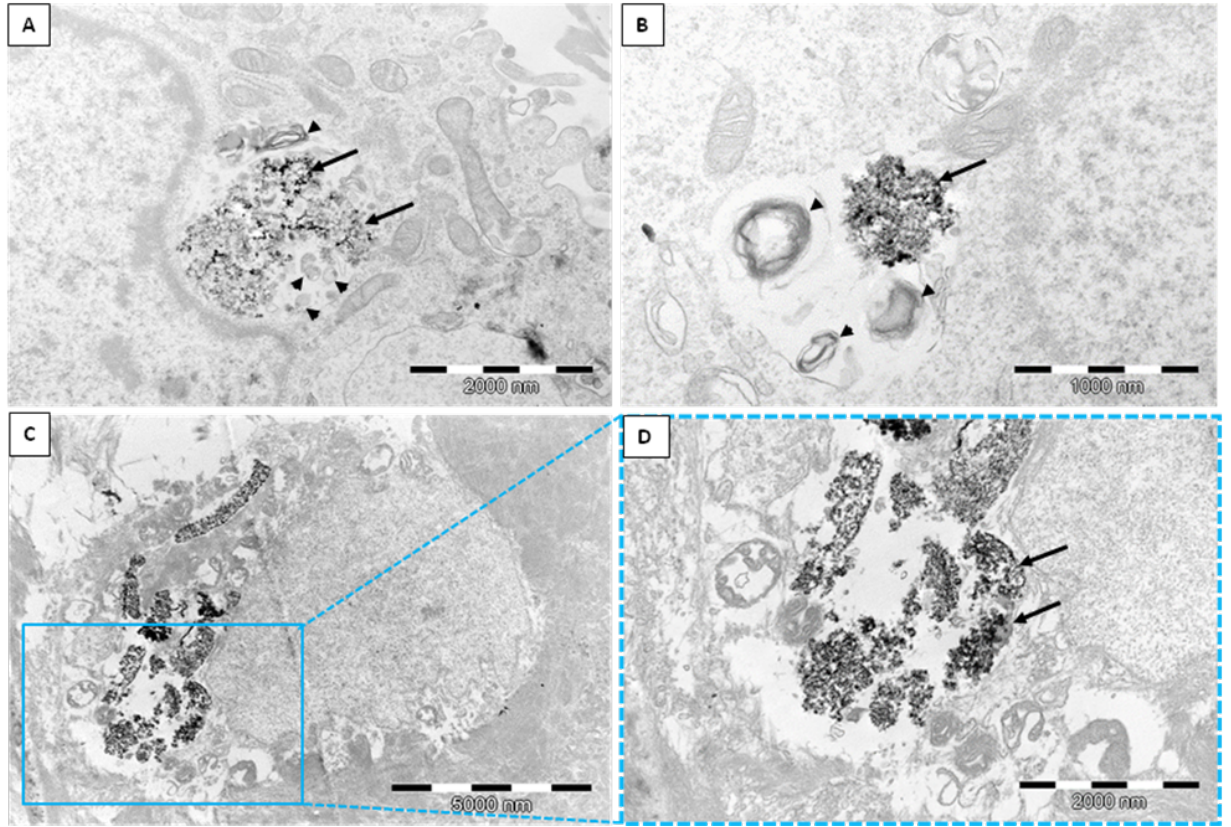
Figure 3. Autophagy and necrosis of HMEC-1 cell line after exposure to silica nanoparticles. ( A , B )—silica nanoparticles internalized into autophagolysosomes (arrows). Cellular debris is also visible inside the autophagolysosomes (arrowheads). ( C , D )—cell necrosis after internalization of bio SiO2. The disruption of cytoplasmic constituents is conspicuous.